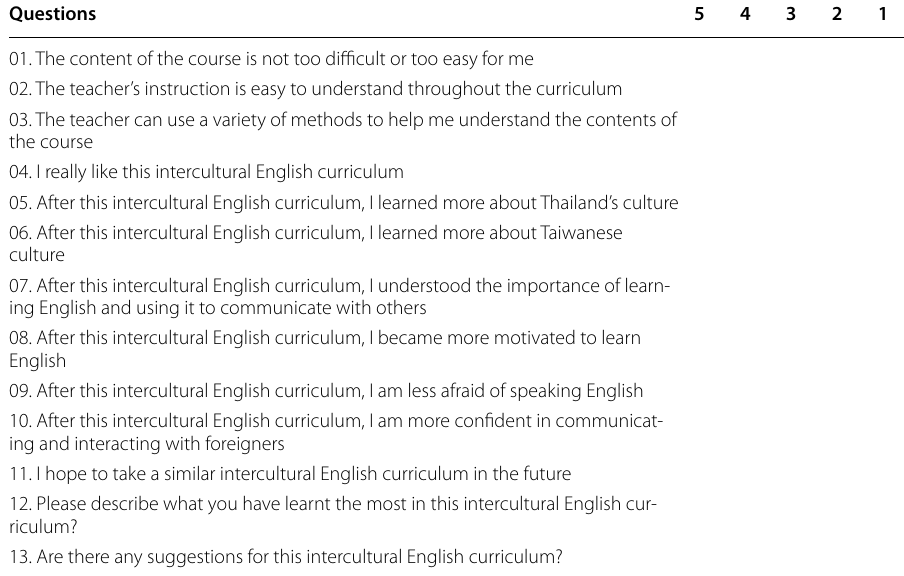
Strongly agree (5); Agree (4); OK (3); Disagree (2); Strongly disagree (1)